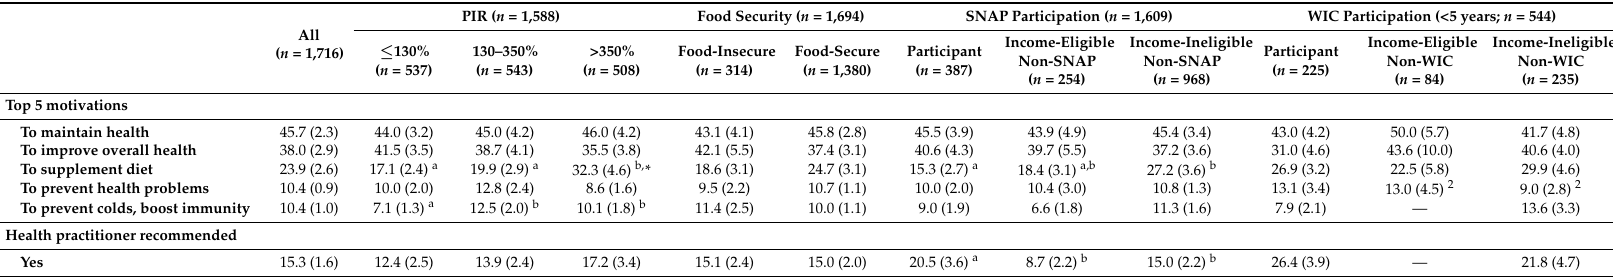
Abbreviations: NHANES, National Health and Nutrition Examination Survey; PIR, family income-to-poverty ratio; SNAP, Supplemental Nutrition Assistance Program; WIC, the Special Supplemental Nutrition Assistance Program for Women, Infants, and Children. 1 Estimates with different letter subscripts (i.e., a or b) are significantly different across subgroups within each indicator category at p < 0.0167; asterisk (*) indicates significant linear trend across PIR subgroups at p < 0.0167. 2 The relative SE is >30% but ≤ 40% and may be statistically unreliable. If the relative SE > 40%, data are not shown (—). Table 4. Estimated percentage (%(SE)) of multivitamin-mineral users ( ≤ 18 years) and motivations for use in a 30-day period by economic indicators, NHANES 2011–2014 1,2 .